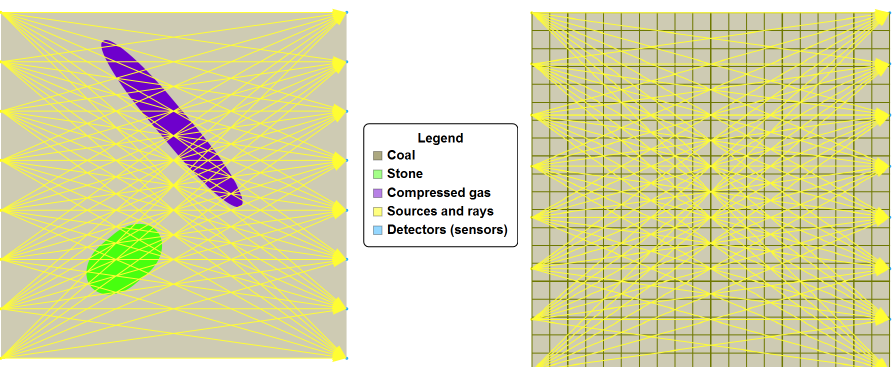
Figure 1. Graphical interpretation of obtaining the projection vector B and the coefficient matrix A of system (2).